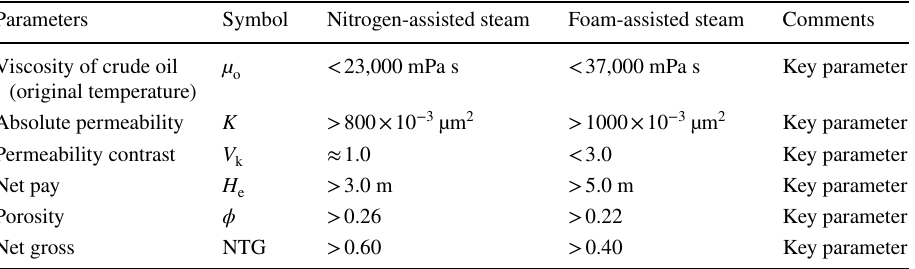
Table 5 The effectiveness of measures for different low production wells